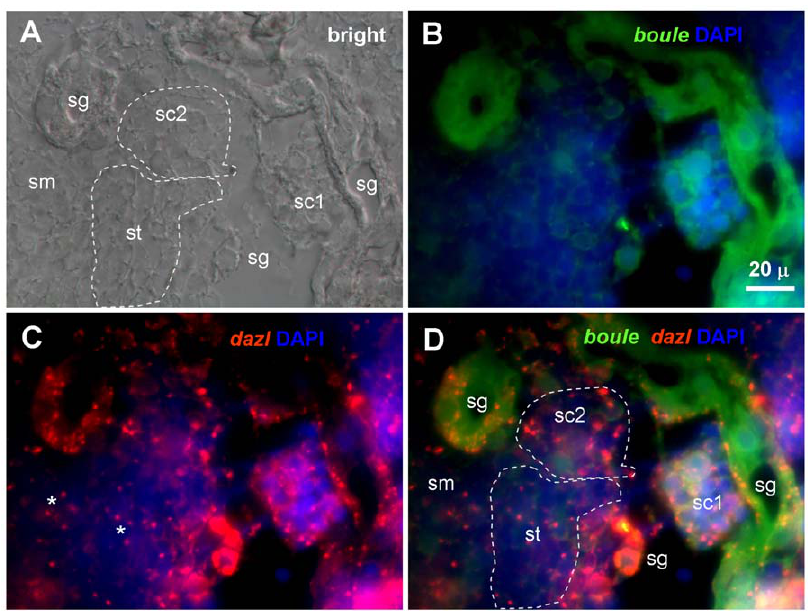
Figure 9. Expression of boule and dazl transcripts in trout spermatogenesis. Adult testicular cryosections were hybridized to antisense RNA probes and the signals were visualized by fluorescence staining. Nuclei were stained blue by DAPI. (A) Bright field. (B) boule signal. (C) dazl signal. (D) Merge. Different stages of spermatogenesis are indicated: sg, spermatogonia; sc1, primary spermatocytes; sc2, secondary spermatocytes; st, spermatids; sm, sperm. The boule RNA forms the diffuse signal, whereas the dazl RNA forms speckles in spermatogonia and spermatocytes, and condenses in the chromatoid body (asterisks) of spermatids and sperm. Scale bars, 20 m m.